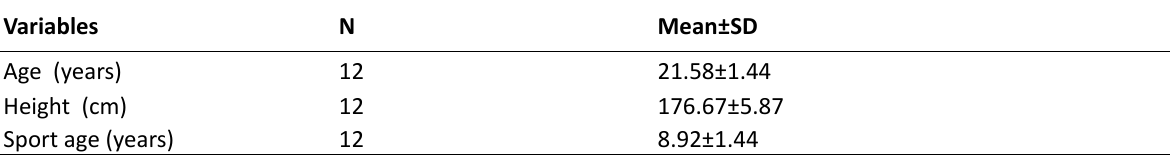
Table 2. Descriptive data of all participants Variables